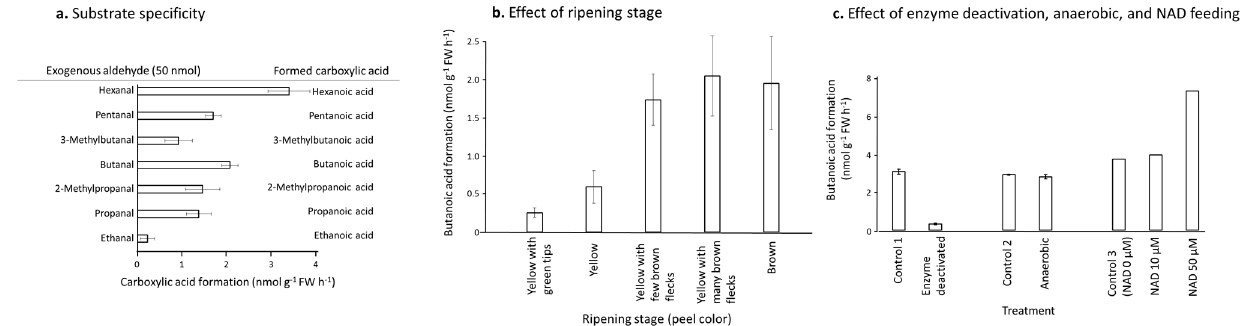
Figure 4. Aldehyde feeding experiments and production of corresponding carbolic acids in banana pulps. Exogenous aldehyde (50 µmol) on filter paper was fed into 10 g of banana pulp tissues. ( a ) Substrate specificity of C2–C6 branched and straight chain aldehydes at the “yellow with green tips” stage (banana pulp slices); ( b ) Effect of ripening stage (pulp homogenate); ( c ) Effects of enzyme deactivation by heat, anaerobic incubation, and feeding of NAD+ at different levels (pulp homogenate). Vertical/horizontal line at each column shows average ± SD (n = 3).